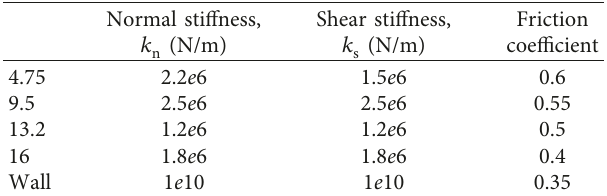
Table 3: Mapping area calculations for three-phase structures. Container